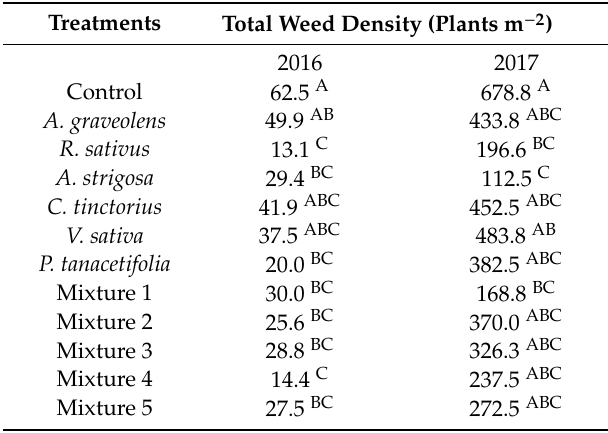
Table 3. Total weed density for the six single sown and five cover crop mixtures 12 weeks after sowing in 2016 and 2017. Di ff erent capital letters within one column show significant di ff erences according to Tukey-HSD test ( p ≤